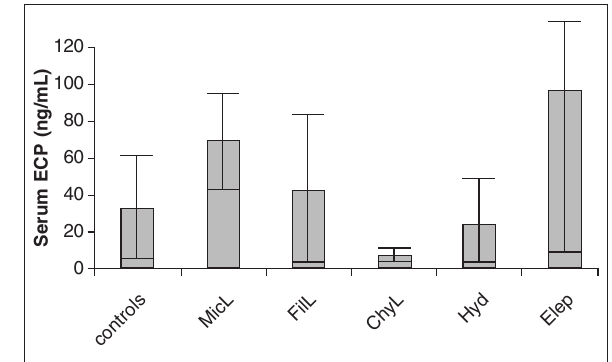
Fig. 4. – Eosinophil Cationic Protein (ECP) levels, determined by ELISA, in sera of patients with lymphatic filariasis according to their clinical status. FilL: filarial lymphangitis; ChyL: chyluria; Hyd: hydrocoele; EleP: ele- phantiasis, in comparison with controls and bacterial lymphangitis